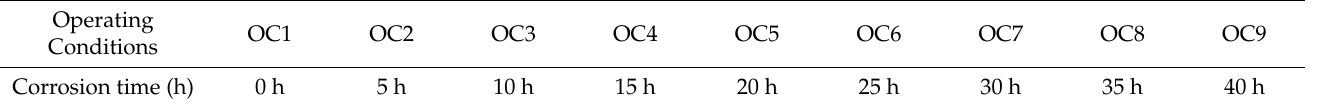
Table 3. Testing operating